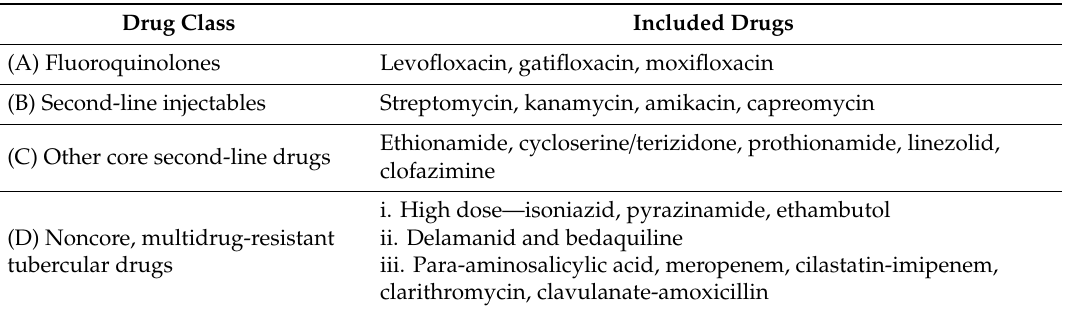
Table 1. WHO classification of antitubercular